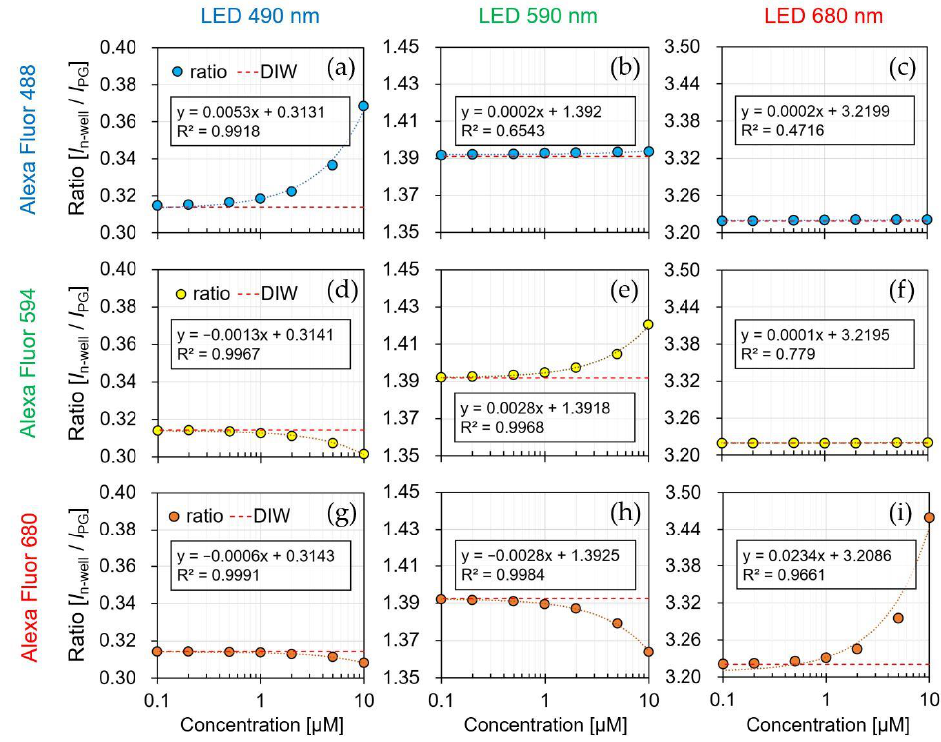
Figure 11. Current ratio by the concentration of fluorescent reagent. ( a ) AF488- λ em : 490 nm; ( b ) AF488- λ em : 590 nm; ( c ) AF488- λ em : 680 nm; ( d ) AF594- λ em : 490 nm; ( e ) AF594- λ em : 590 nm; ( f ) AF594- λ em : 680 nm; ( g ) AF680- λ em : 490 nm; ( h ) AF680- λ em : 590 nm; ( i ) AF680- λ em : 680